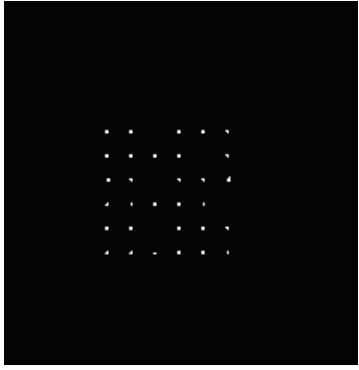
Figure 14. The image with one–five missing sun spots.